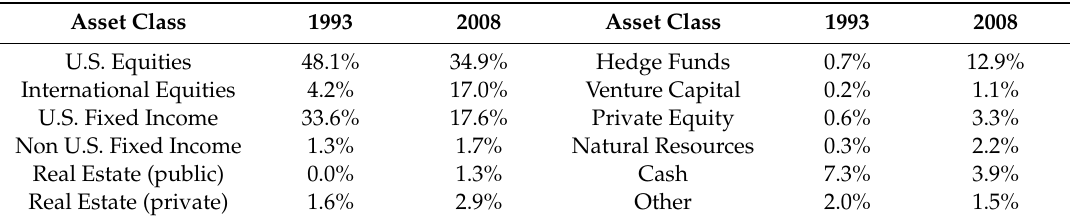
Table 1. Shifts in University Endowment Asset Allocations, 1993–2008 (Percentages of Equal-weighted Endowment